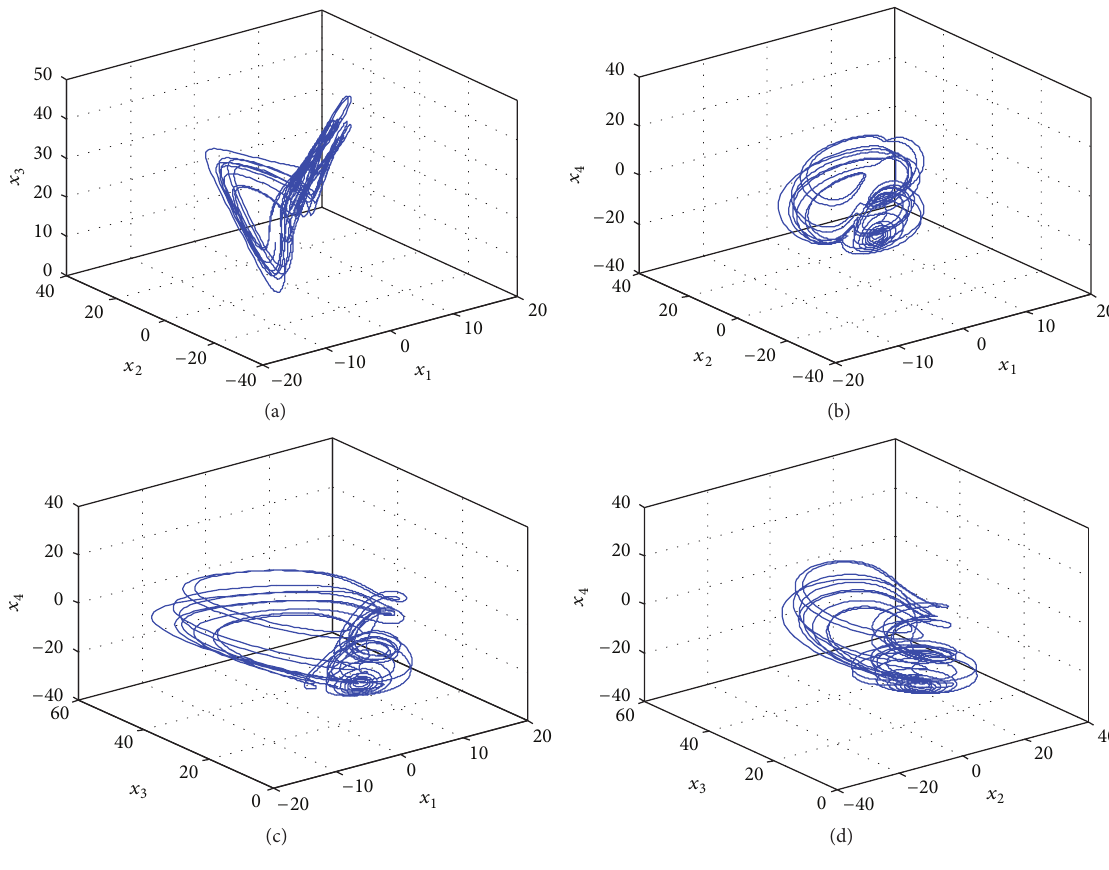
Figure 1: Projections of phase portrait for master system